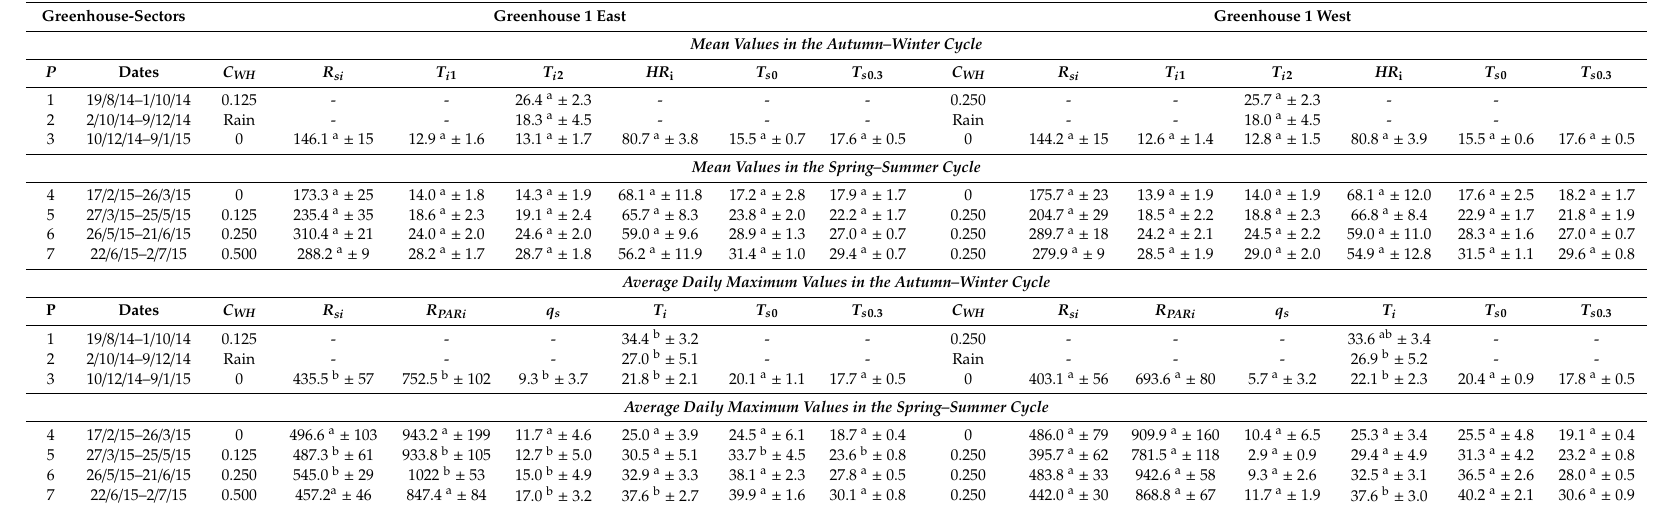
Table 3. Mean and average maximum ( ± standard deviation) values of air temperature recorded inside the east and west sectors of the experimental greenhouse 1 at 2 m height T i2 ( ◦ C) for the di ff erent periods P and whitening concentrations C WH (kg L − 1 ). Air temperature at 1 m height T i1 ( ◦ C), relative air humidity of inside air HR i (%), soil surface temperature T s0 ( ◦ C), temperature of the soil at 0.3 m depth T s 0.3 ( ◦ C), inside solar radiation R si (W m − 2 ), inside PAR radiation R PARi (W m − 2 ), and soil heat conducted in the soil at 0.2 m q s (W m − 2